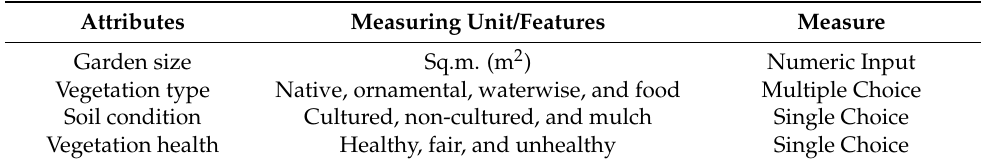
Table 2. Unit of measurement for the rapid verge garden